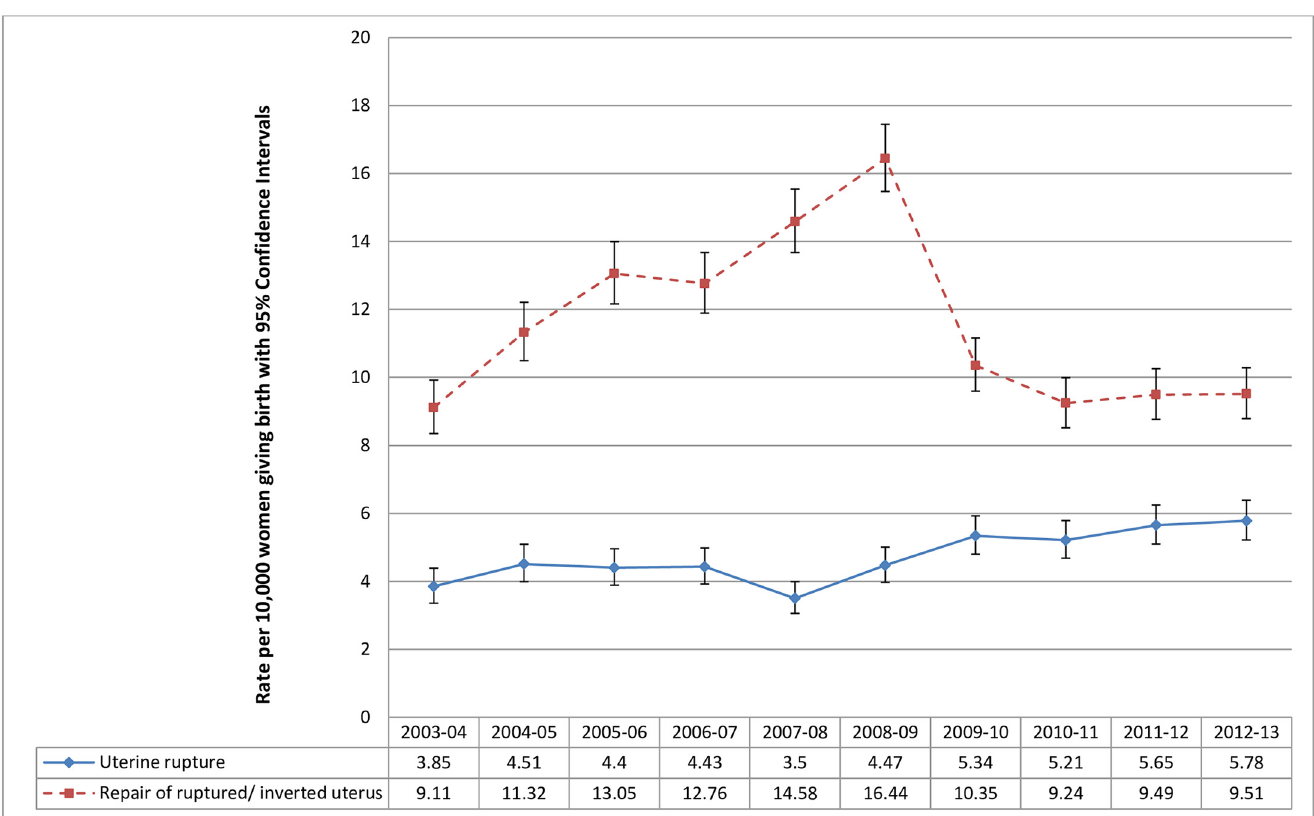
Fig 2. Comparison of the estimated rates of uterine rupture and repair of ruptured or inverted uterus among women giving birth in England from 2003 to 2013; Hospital Episode Statistics data